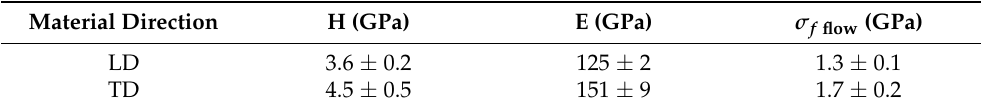
Table 4. Summary of the mechanical properties (hardness, elastic modulus and flow stress) deter- mined using the nanoindentation technique and obtained as an average from the stabilized zone for the commercial Ti-6Al-4V alloy as a function of the material direction. Material Direction H (GPa) E (GPa) σ f flow (GPa)